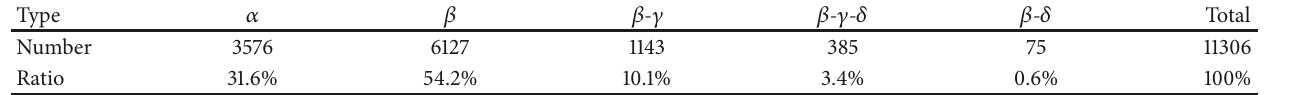
Table 1: Distribution of magnetic types in 1592 ARs recorded in SRS files.